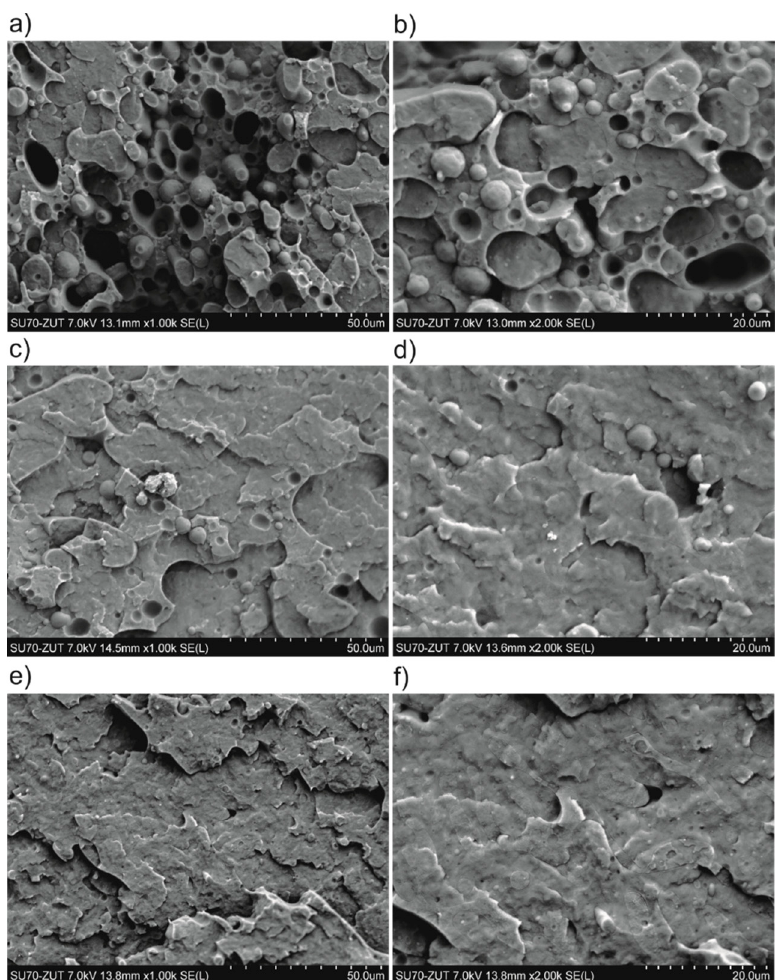
Figure 16. Micrographs of fracture surfaces of PP / PBT blends at di ff erent magnifications (x1000; x2000): ( a , b ) PP / PBT 50 / 50; ( c , d ) PP / PBT 50 / 50 + 5 wt% PBT–DLA; ( e , f ) PP / PBT 50 / 50 + 5 wt% SEBS.